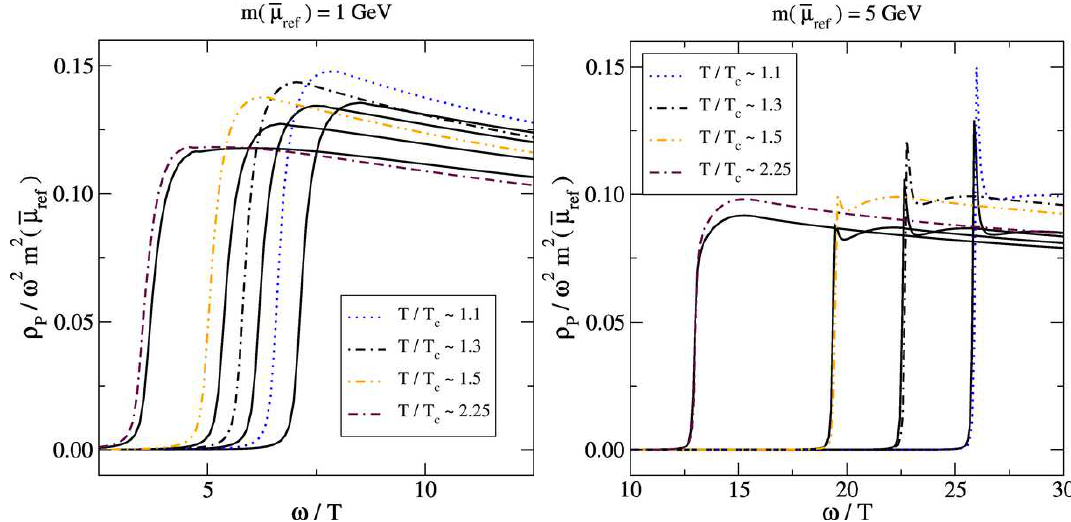
Figure 7 . Perturbative spectral functions (dash-dotted curves) and their modifications according to eq. (6.1) (continuous curves), for charmonium (left) and bottomonium (right). The continuous curves on the left yield the imaginary-time correlators labelled by “model” in figure 6, which agree well with lattice data at all distances. These results are elaborated upon in the paragraphs following eq.